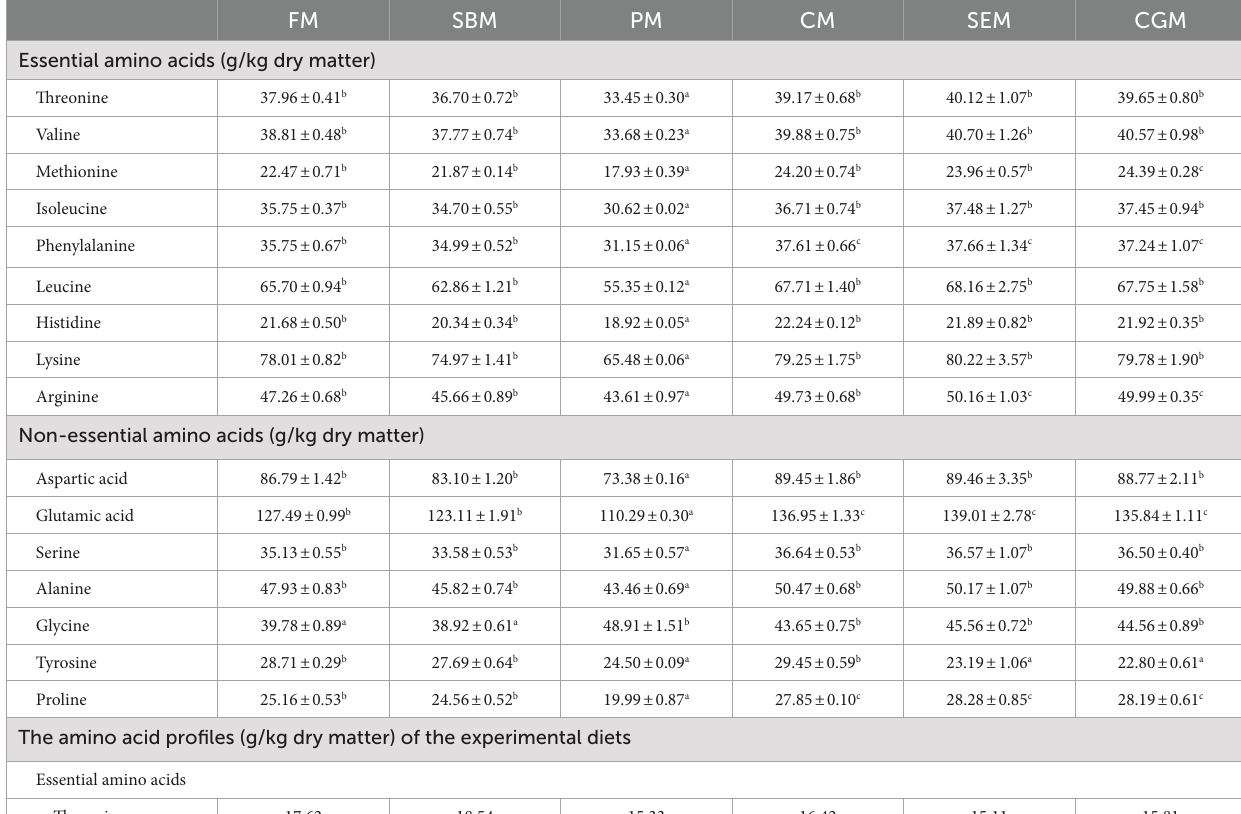
TABLE 5 Effect of five typical plant proteins partially replacing fish meal on the amino acid content and fatty acid composition of muscle in yellow catfish. FM SBM PM CM SEM